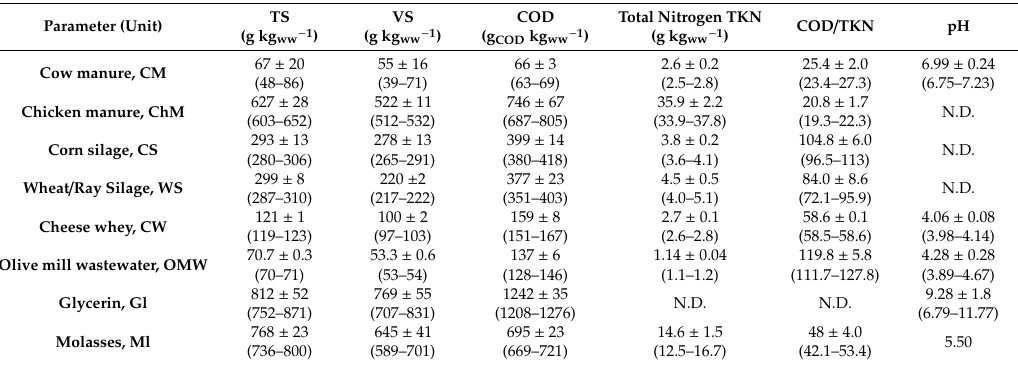
Table 1. Feedstocks’